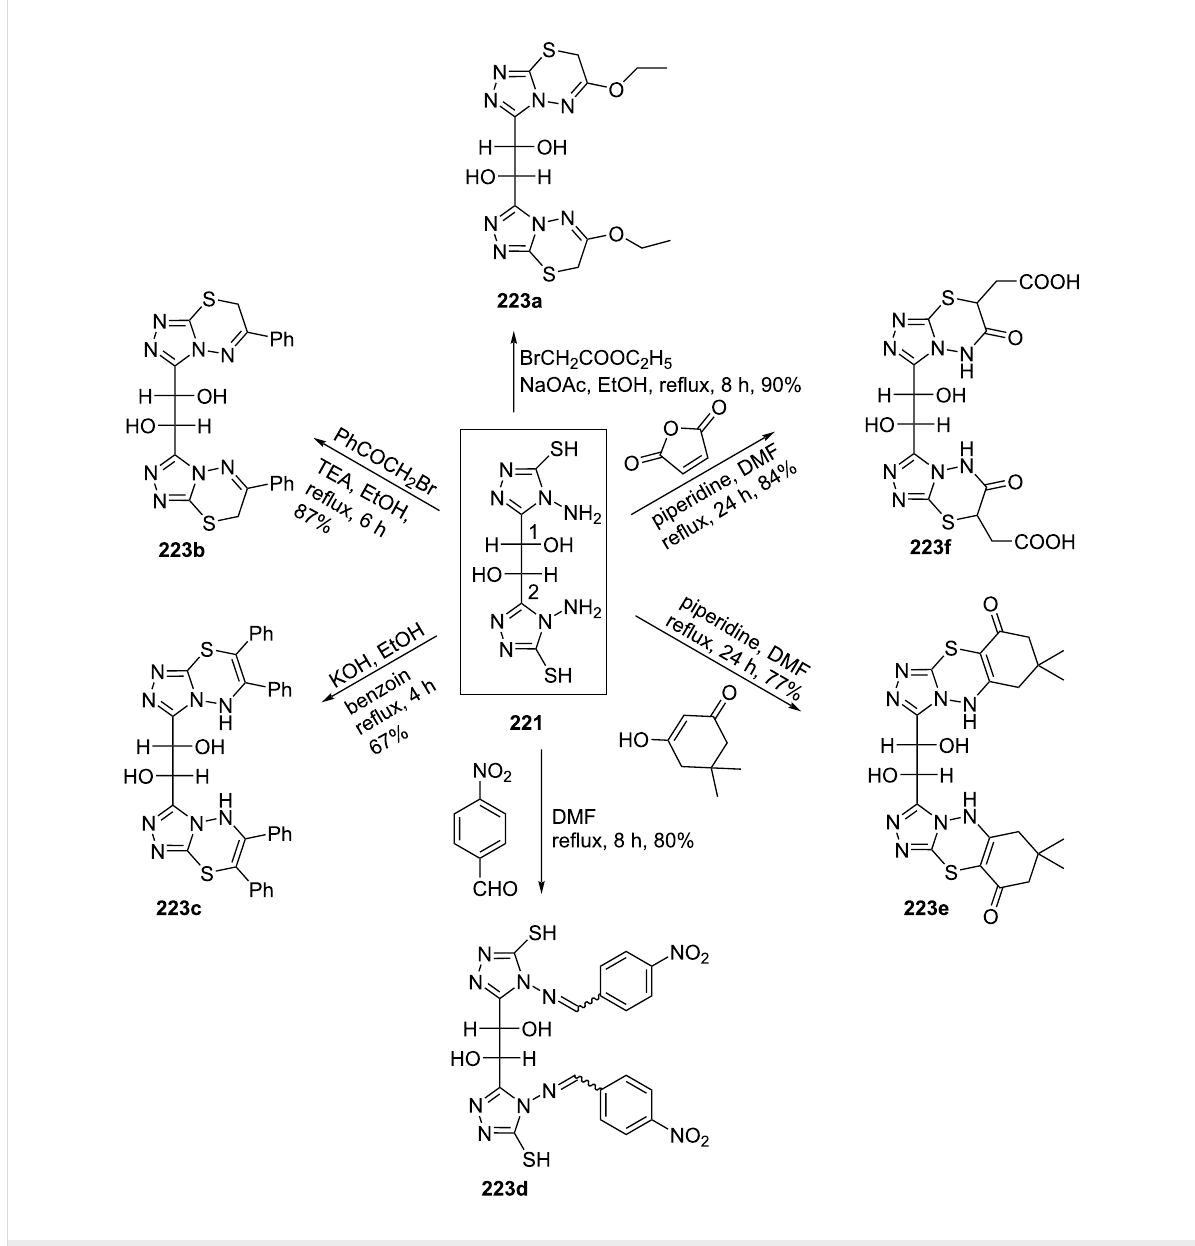
Scheme 60: Synthesis of functionalized 1,2-bis(1,2,4-triazol-3-yl)ethane-1,2-diols 223a–f .